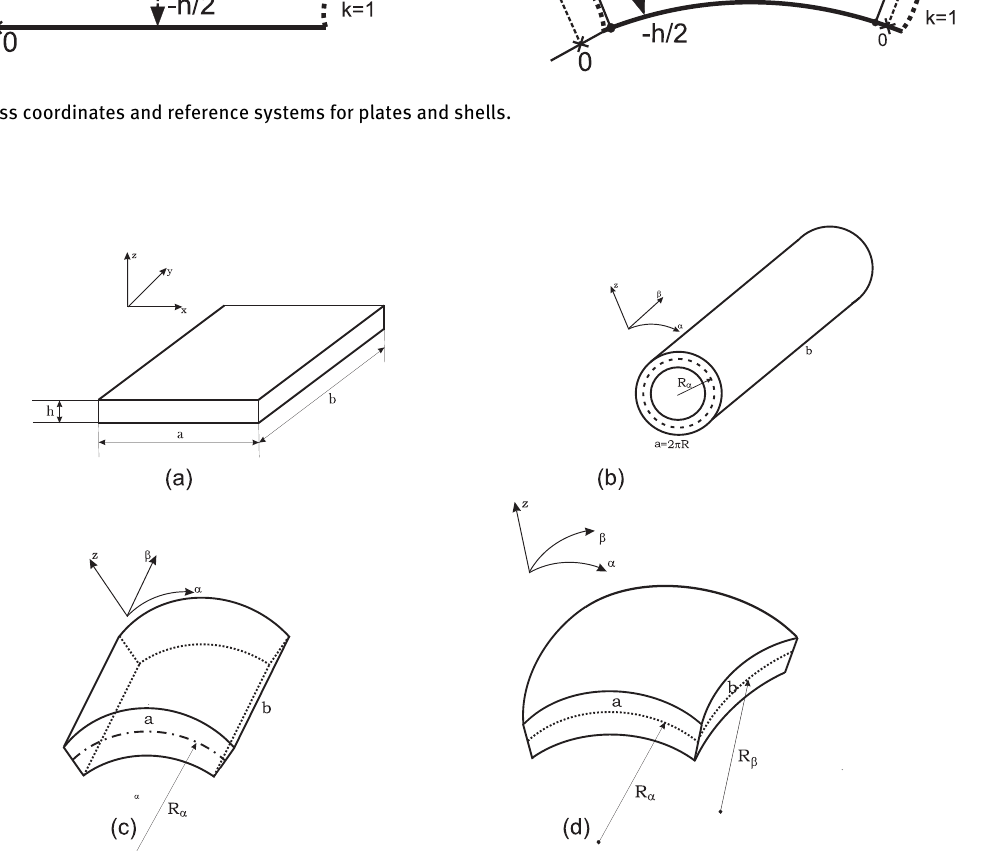
Figure 3: Geometries for assessments (structures a-d) and for benchmarks (structures a and b).